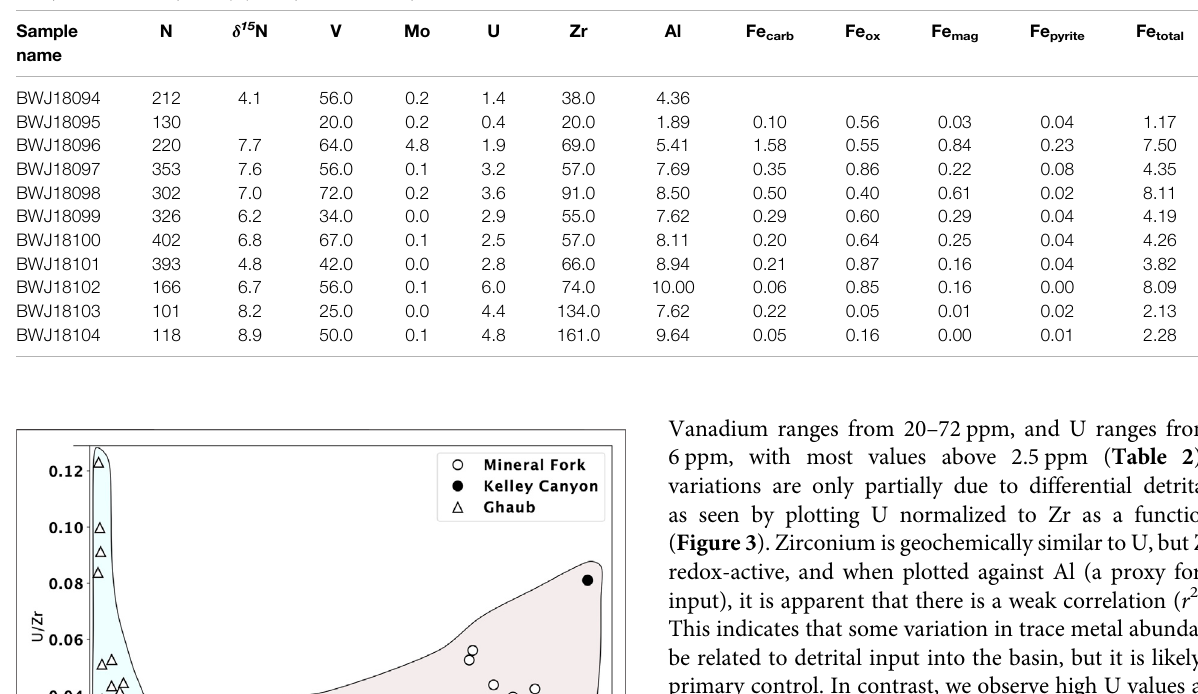
TABLE 2| Geochemical datapresented in text. Nitrogen and trace element concentrations are given in ppm, whileAland Fe speciation data arein weight percent. Nitrogen isotope values are in permil (%), compared to atmospheric N 2 .